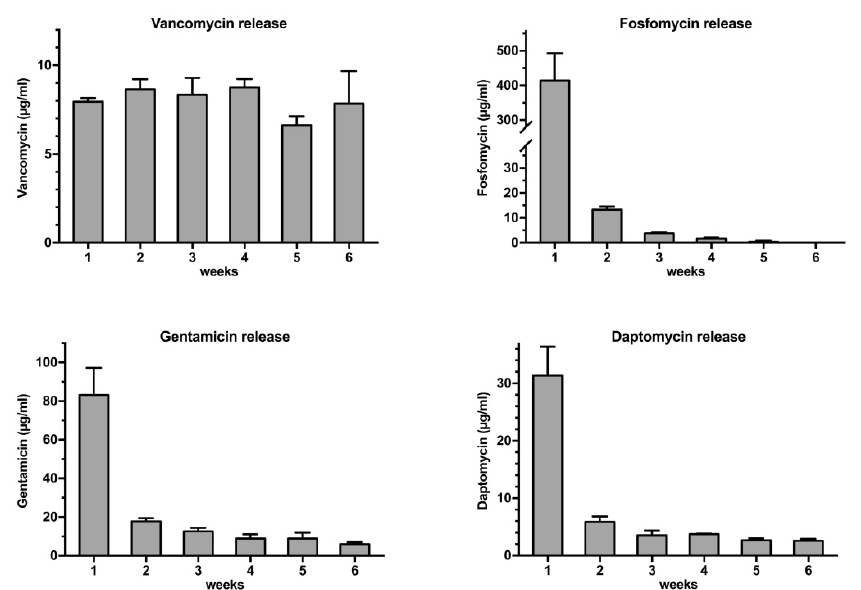
Figure 1. Antibiotic release in PBS at 37ºC during 6 weeks . Mean and standard deviation of triplicate